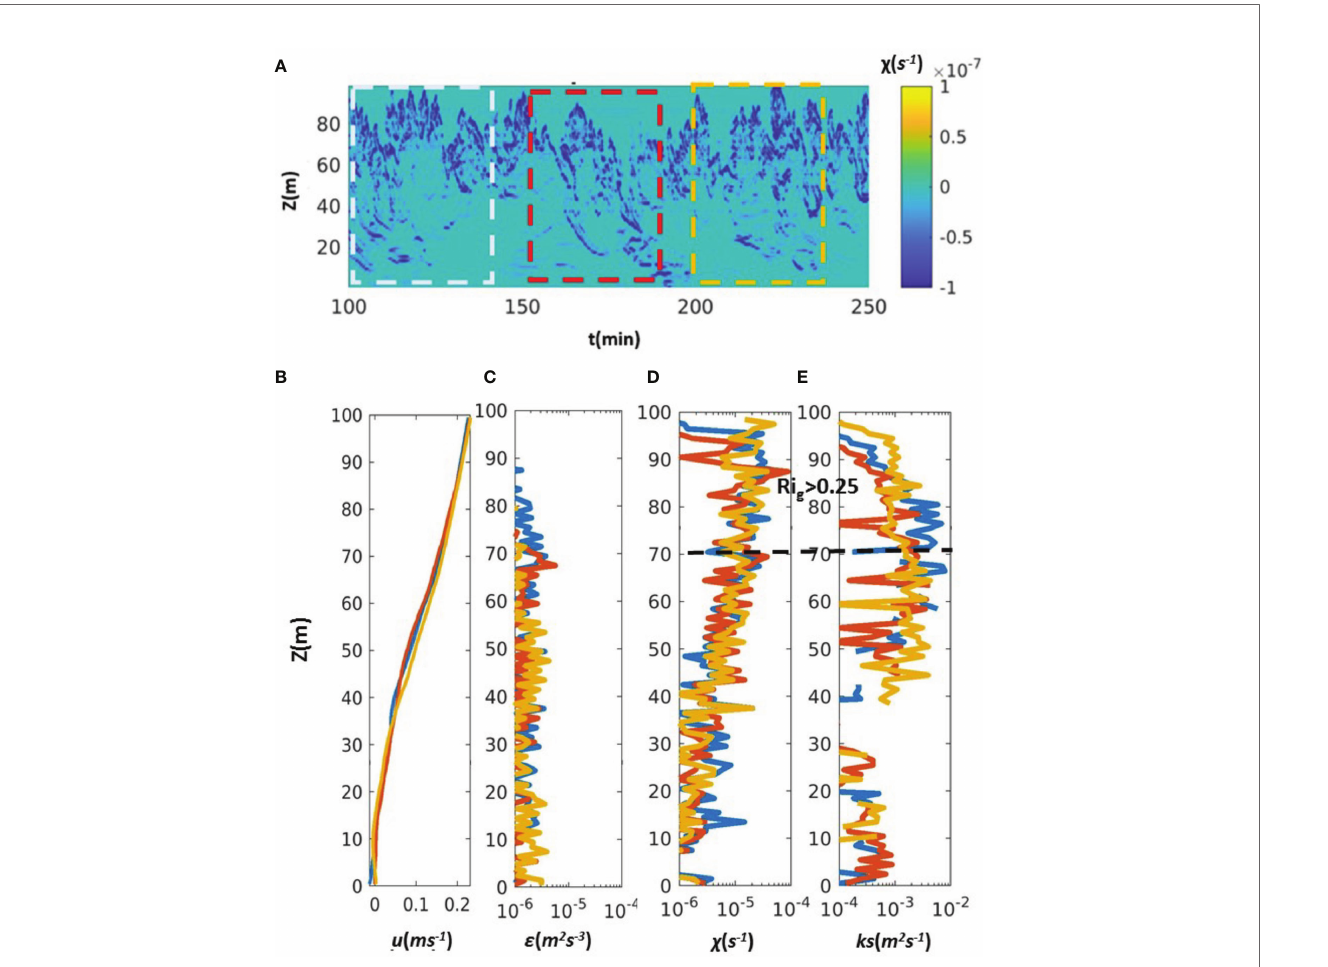
FIGURE 9 | Model results of Case C: the time series of (A) density variance dissipation. The blue, red, and orange lines indicate the interval for 30 minutes time average. (B) The time average pro fi les of fl ow shear, (C) TKE dissipation rate, (D) density variance dissipation, and (E) eddy diffusivity at location x =800 m (see Figure 4 for the